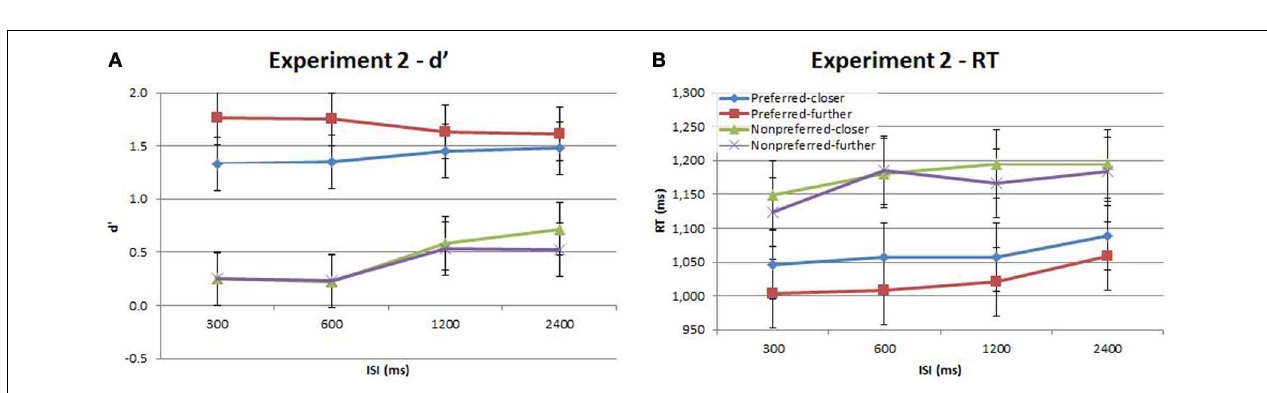
Experiment 1—accuracy (d (cid:2) ). (B) Experiment 1—response time (RT). The star on the y-axis indicates that Experiment 1 participants were only presented with an ISI of 600ms during the titration procedure. Vertical bars represent within-subject SEM for the distance factor.